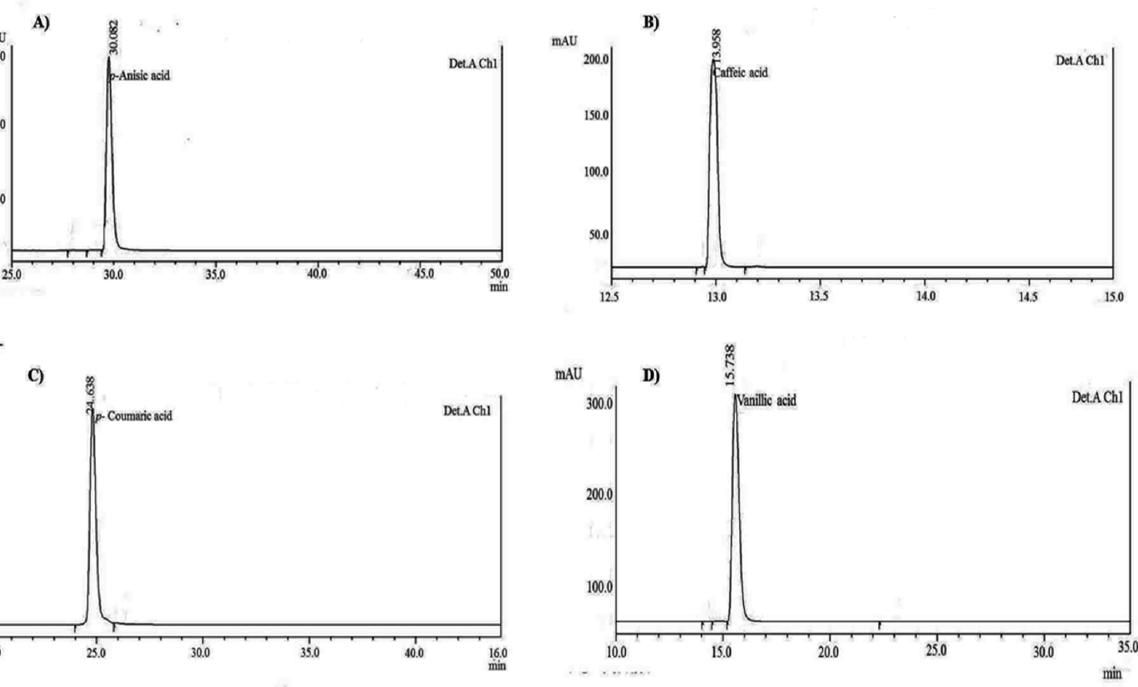
Figure 3. HPLC chromatogram for purity check of individual compounds isolated from the extracts of H. pinifolia. ( A ). p- Anisic acid; ( B ). Caffeic acid; ( C ). p- Coumaric acid; ( D ). Vanillic acid; ( E ). Rosmarinic acid. 3.5. Alternative Screening Approach for C. albicans Growth in YNB Broth In this study, the growth of C. albicans in YNBL medium was determined, and the cut-off value was set at 40% growth reduction with respect to the drug-free control. Ita- conic acid and fluconazole were used as positive controls. Among the five compounds, rosmarinic acid showed the minimum growth percentage of 1.99%, as it inhibited the growth of C. albicans , followed by p -anisic acid (34.4%), caffeic acid (48.2%), p -coumaric acid (76.3%), and vanillic acid (85.4%). Furthermore, growth assessment in YNBG medium helped to get a narrow list of potential ICL inhibitors (rosmarinic acid, p -anisic acid, and caffeic acid) that showed a lactate-specific pattern of growth reduction similar to itaconic acid. In contrast, vanillic